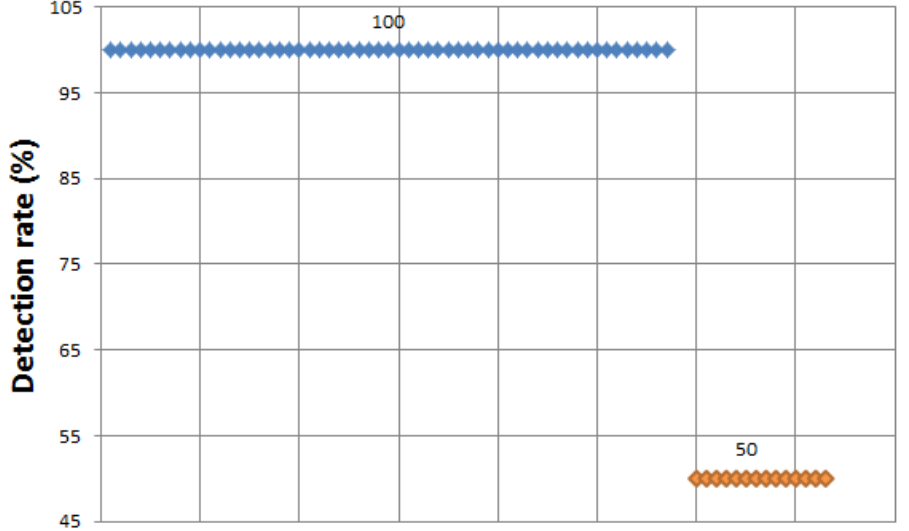
Figure 13. Buffer overflow attack—detection rate (after ADTree, RandomTree,